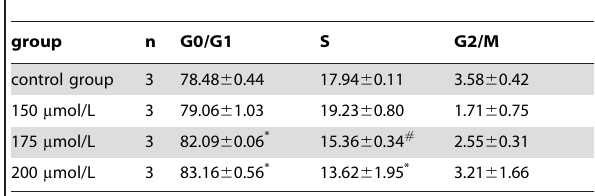
Table 3. Effects of Artesunate on cell cycle of HSCs ( x 6 s).